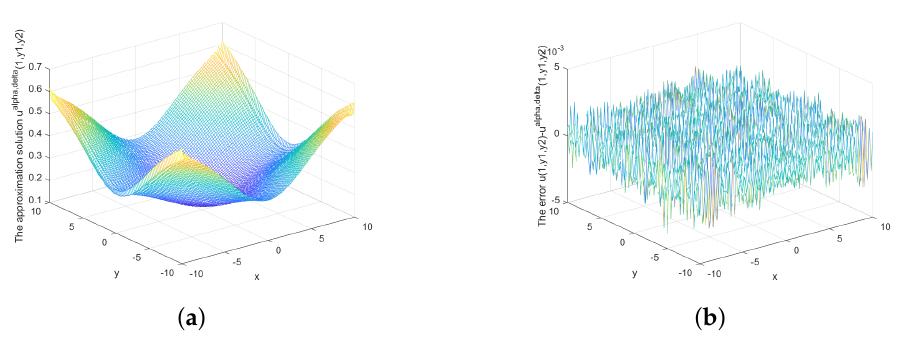
Figure 16. ( a ) The regularized solution and ( b ) error between regularized and exact solution when x = 0.3, δ = 1 × 10 − 5 under posterior rule.